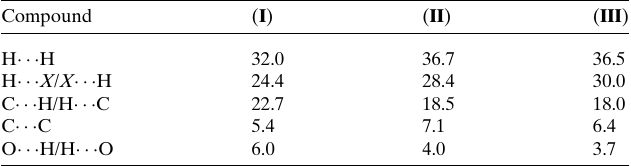
Table 2 Contributions of selected intermolecular contacts